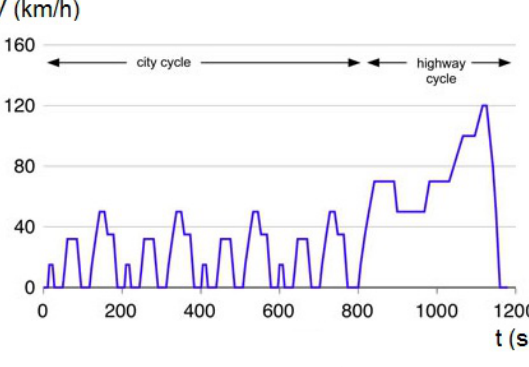
Figure 11: NEDC speed profile.